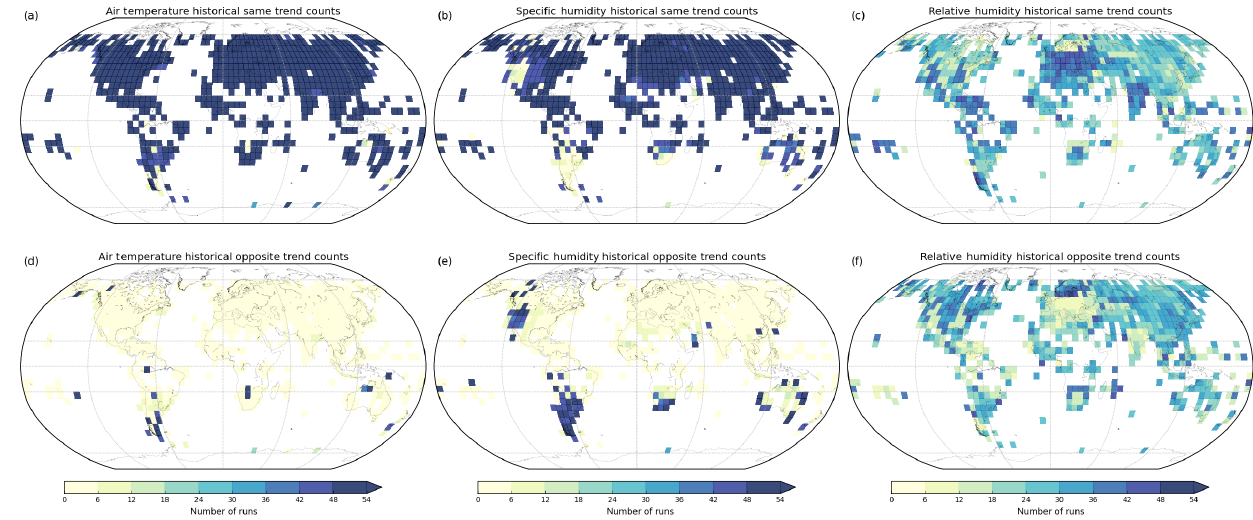
Figure 7. Frequency of historically forced CMIP5 models with trends in the (a, b, c) same direction as HadISDH or (d, e, f) the opposite direction to HadISDH for air temperature, specific humidity and relative humidity